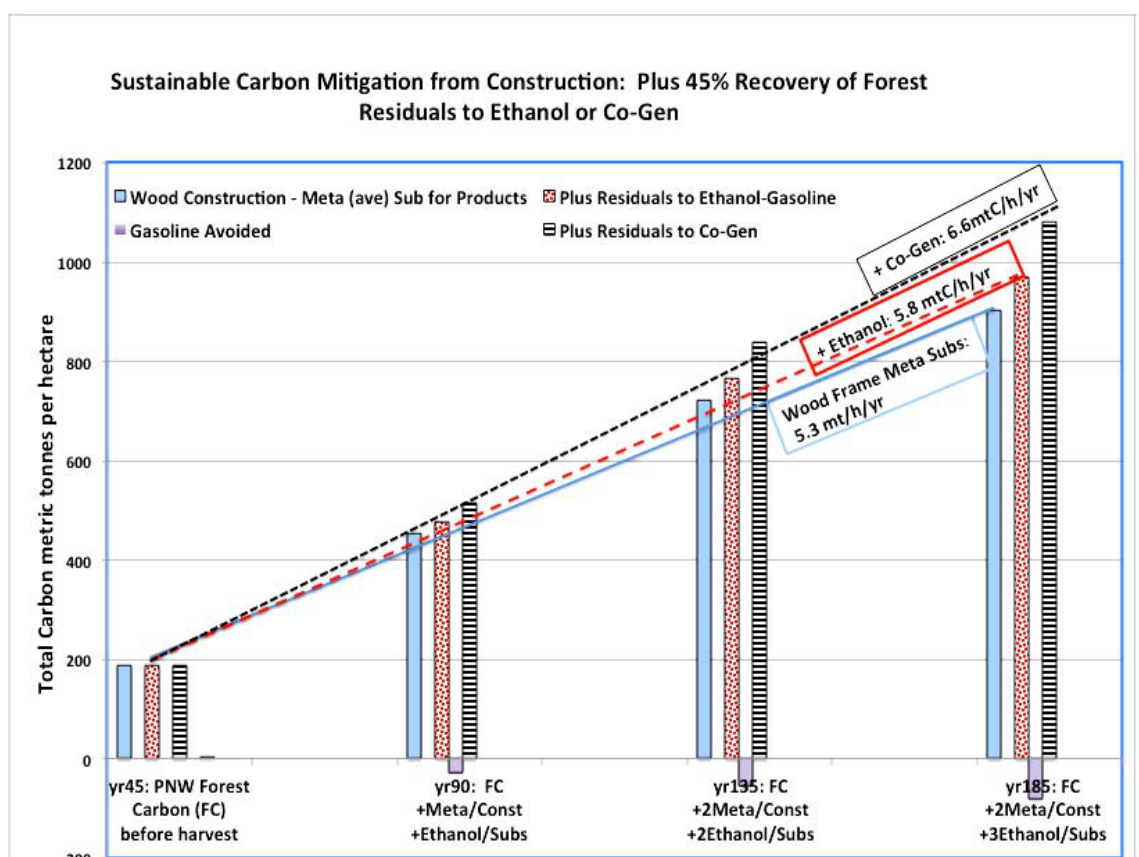
Figure 2. Sustainable carbon mitigation trend from a Pacific Northwest (PNW) forest: ( 1 ) wood frame meta (average) substitution, ( 2 ) addition of ethanol from forest residuals, and ( 3 ) addition of co-gen from forest